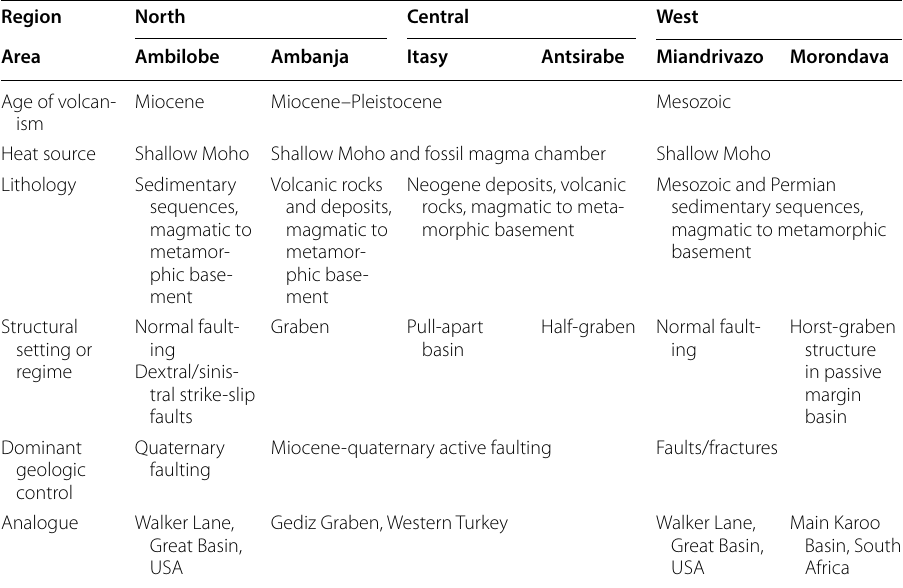
Table 5 Shared features between Madagascar geothermal areas and global analogues Region